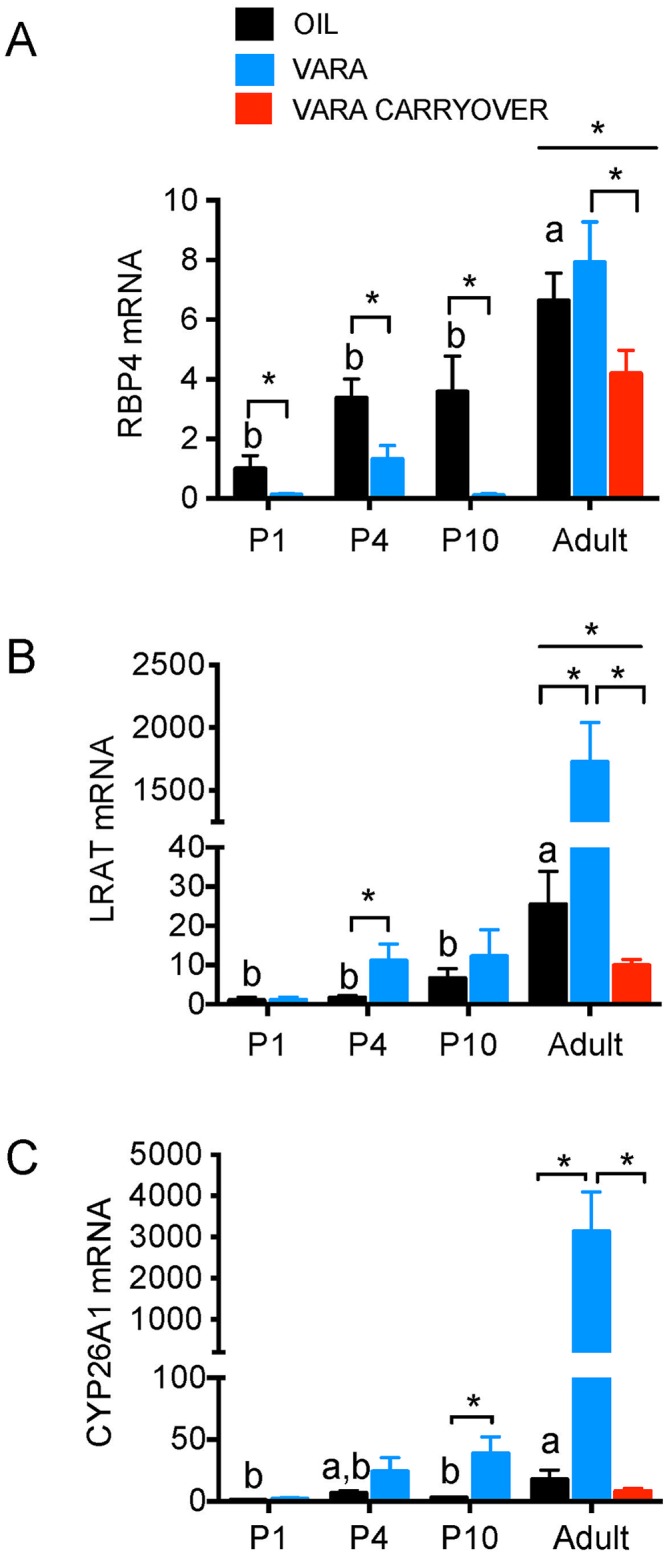
Expression of retinoid homeostatic genes in liver of neonatal rats and adult-age rats fed VAM diet supplemented with or without VARA.Relative levels of mRNA transcripts for Rbp4 (A), Lrat (B), and Cyp26a1 (C) are shown for liver, under experimental conditions described in Fig 1A. Developmental expression patterns in the control group are shown by black bars for Rbp4 (A), Lrat (B), and Cyp26A1 (C) and levels after VARA in blue bars. The group labeled “VARA Carryover” (red bars) received VARA on P1, P4, P7, and P10 as neonates, but were not treated with VARA as adults (see Fig 1A). For comparison of relative values, the average value for the control group (P1, oil) was set to 1.00 for each assay and fold change for each gene is shown as relative to this value. Data are shown as mean ± SEM, n ≥ 5/group. One-way ANOVA with post-hoc analysis was used to determine differences between oil-treated groups at different ages, indicative of differences due to ontogeny. Means without a common letter differ significantly, P < 0.05. For each age, VARA versus Oil groups were compared by t-test; * indicates P < 0.05. Abbreviations: P, postnatal day; VARA, vitamin A combined with 10% retinoic acid; Rbp4, retinol-binding protein 4; Lrat, lecithin:retinol acyltransferase; Cyp26A1, cytochrome P450 family 26 subfamily c polypeptide 1.